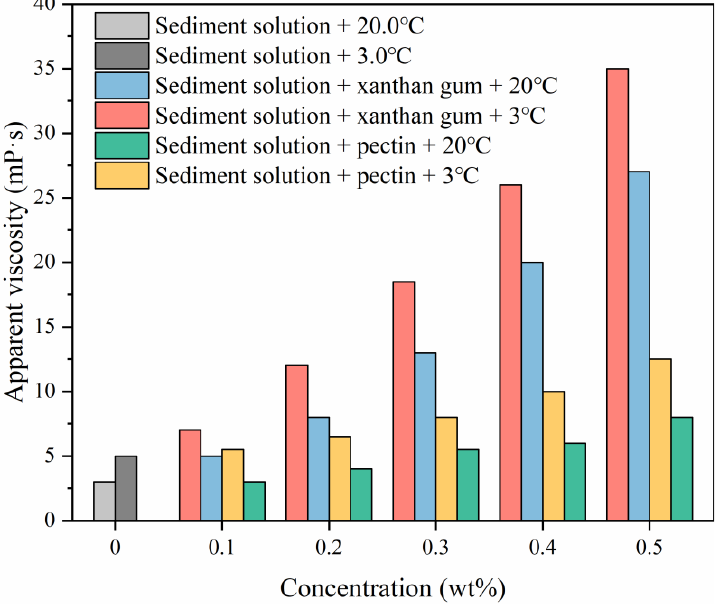
Figure 12. Effects of xanthan gum and pectin on the apparent viscosity of sediment solutions.